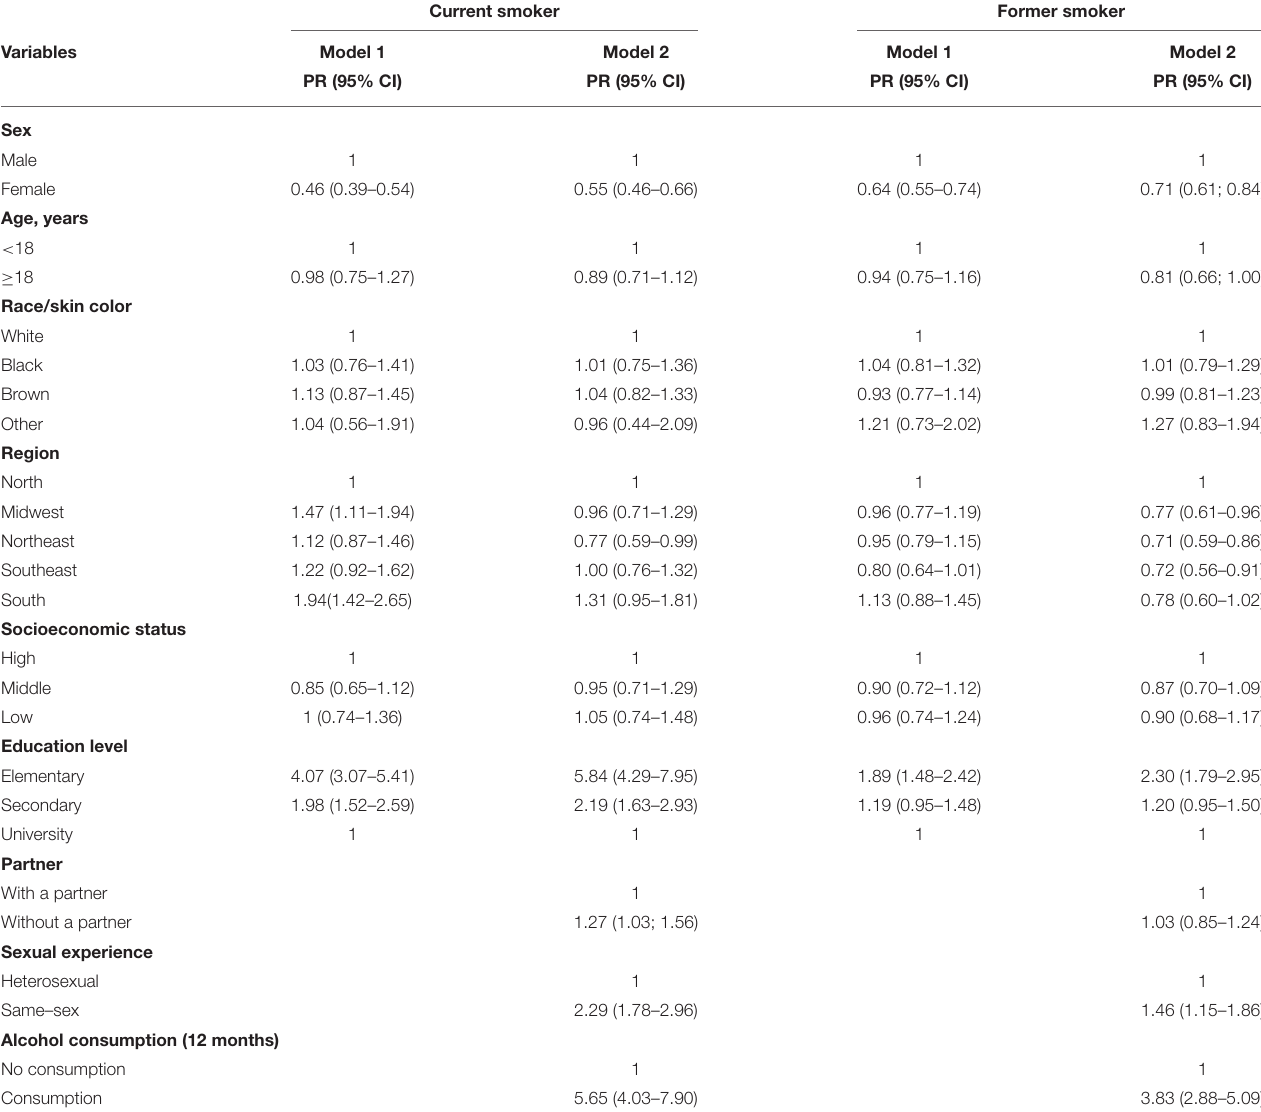
TABLE 3 | Factors associated with smoking in a multivariate analysis of Brazilian population,